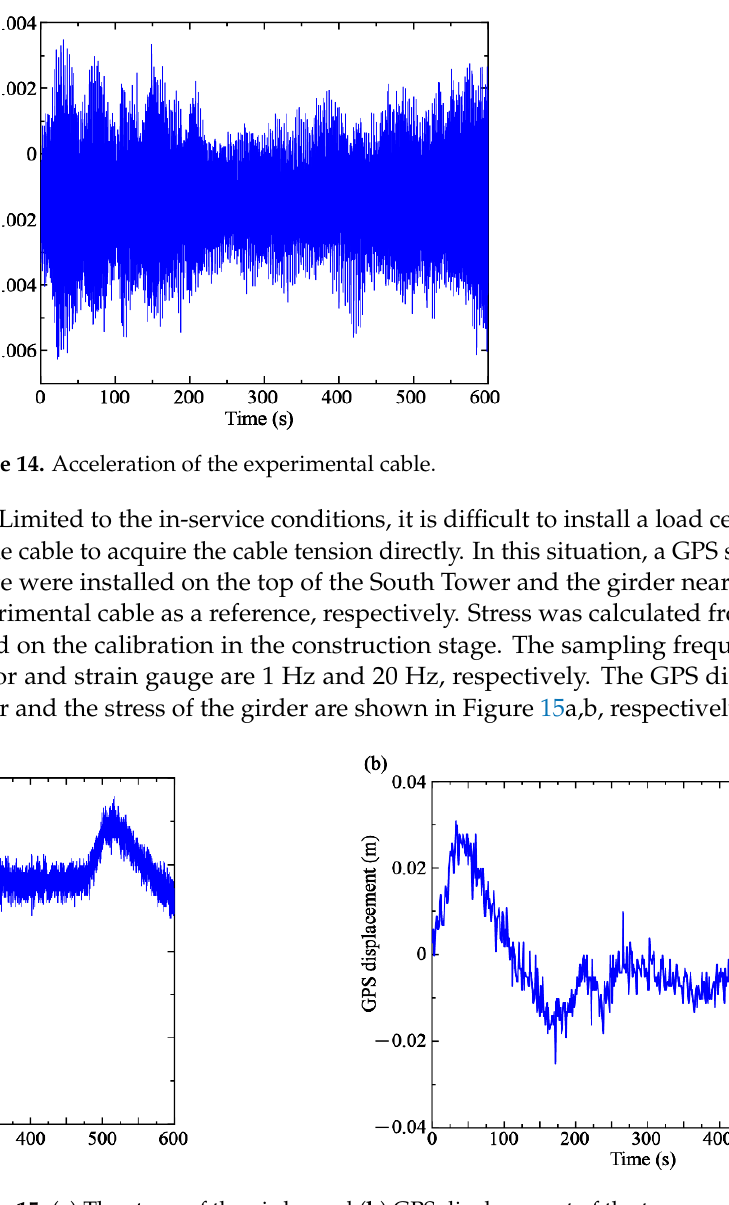
Figure 15. ( a ) The stress of the girder and ( b ) GPS displacement of the tower.